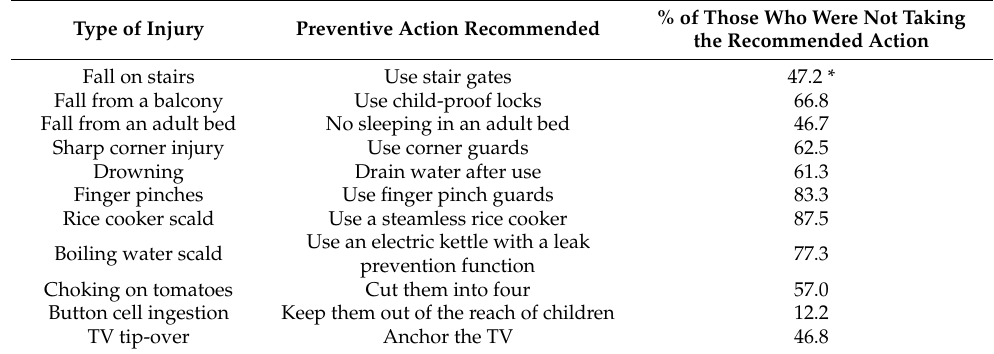
Table 2. Percentage of respondents who were not taking the recommended action by injury